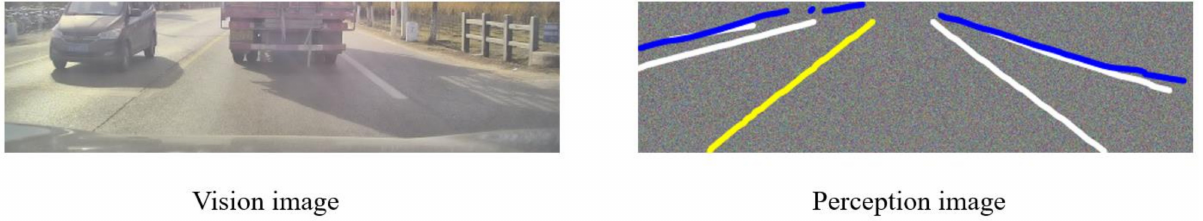
Figure 2. The left image is the vision image extracted from the camera video; the right image is the corresponding perception image. The generating method is drawing the lane marks and road edges in a random image whose shape is the same as the original vision